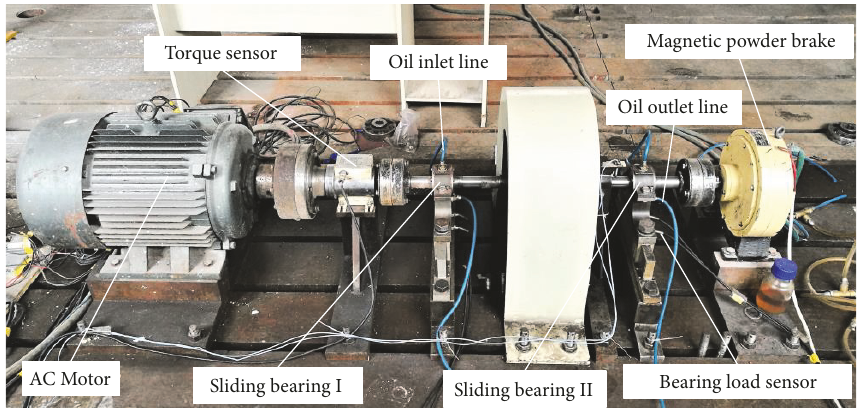
Figure 1: The single-span double-disc rotor test bench.